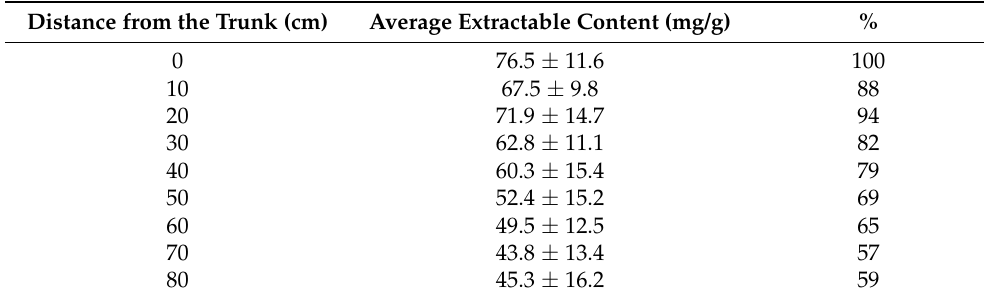
Table 2. Extractable matter content (mean values and standard deviations) in the branches at different distances from the